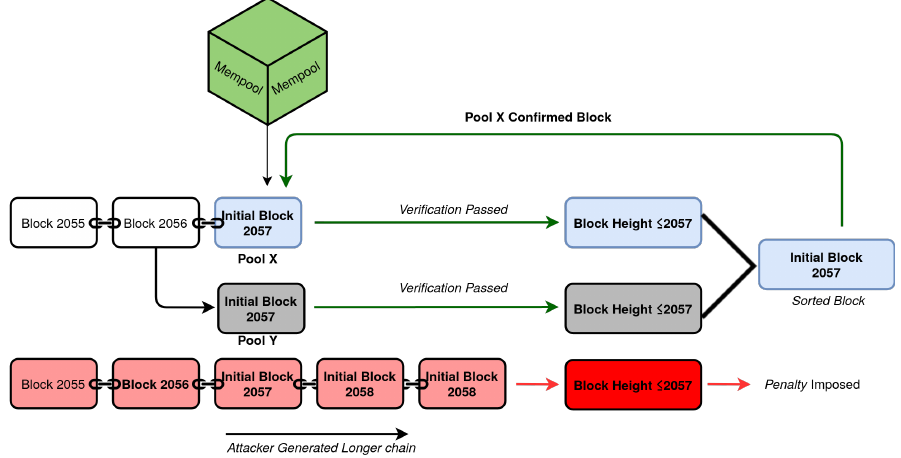
Figure 7. PoAj stopping the 51%